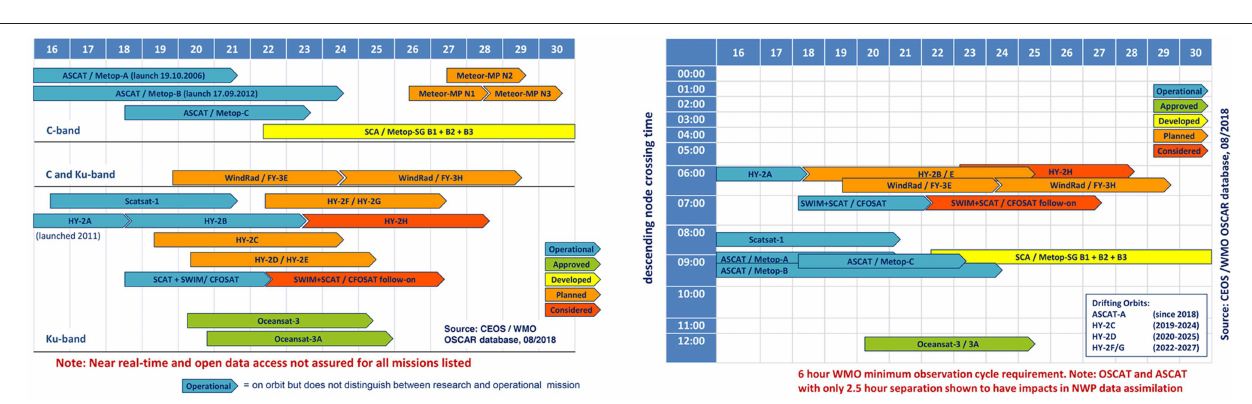
FIGURE 2 | Projection of existing and future scatterometers (left) and sampling through the diurnal cycle (right). While the World Meteorological Organization’s requirement for the number of satellites should be met, the sampling through the diurnal cycle is insufficient. Graphic courtesy of Stefanie Linow.